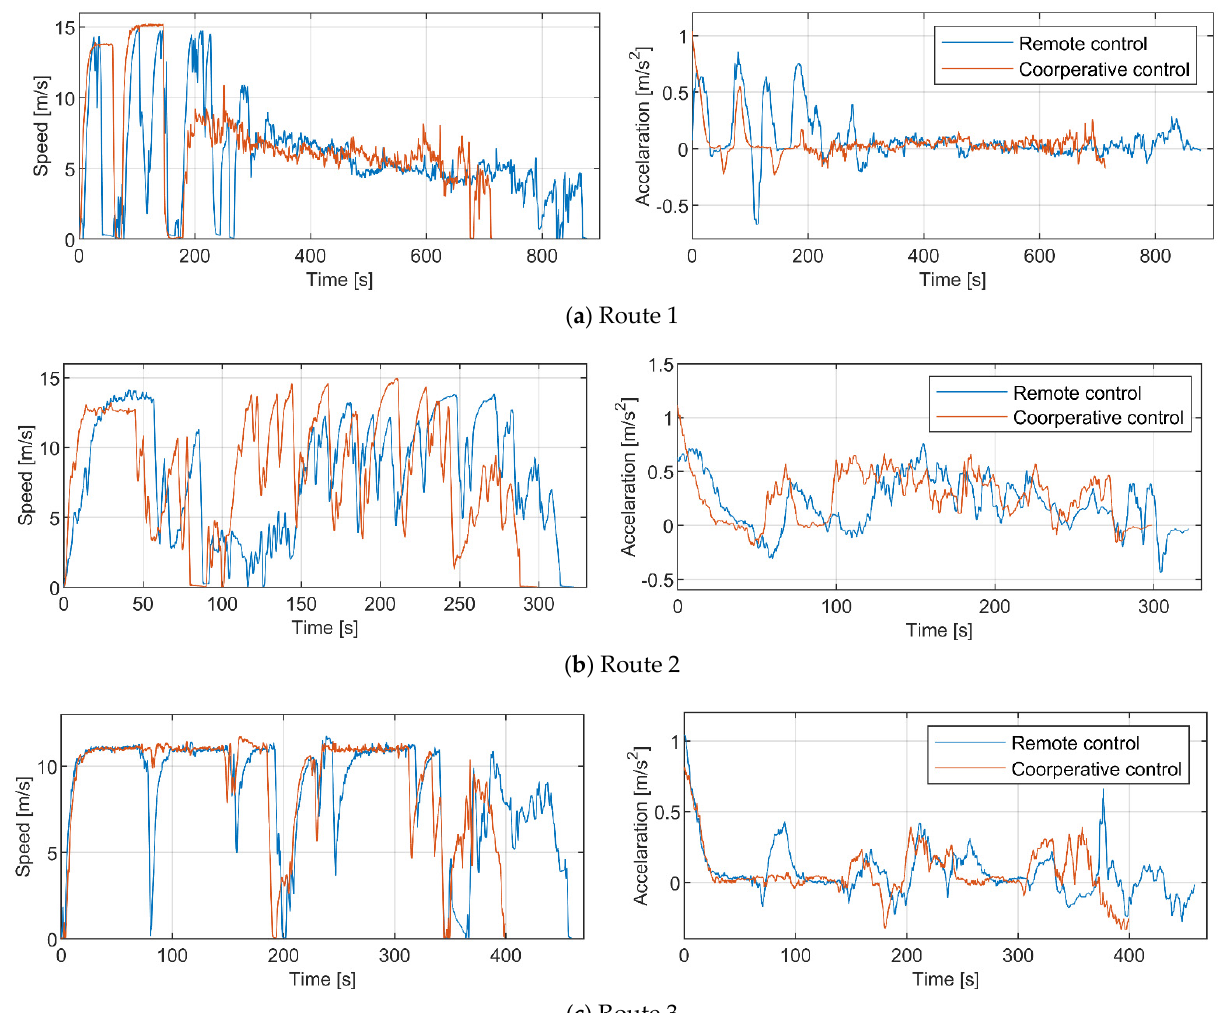
Figure 26. Driving speed and acceleration variation in three test routes based on remote control mode and human-machine cooperative control mode from one of the subjects.